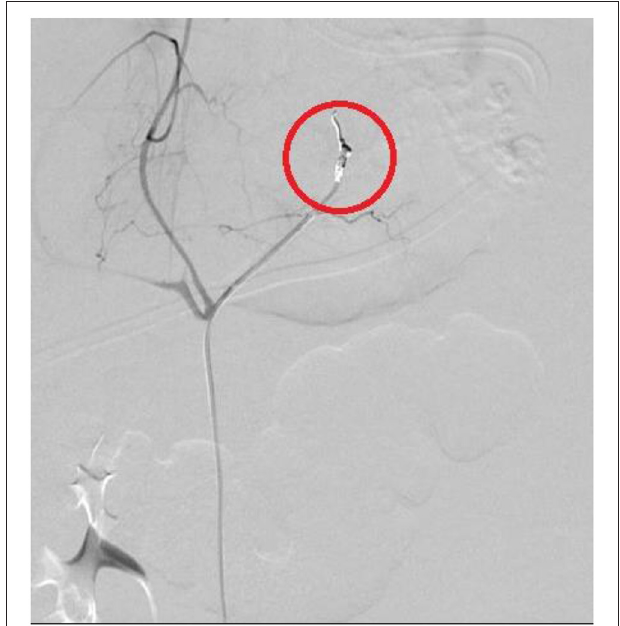
FIGURE 4 | Embolization of left diaphragmatic artery (angiography: